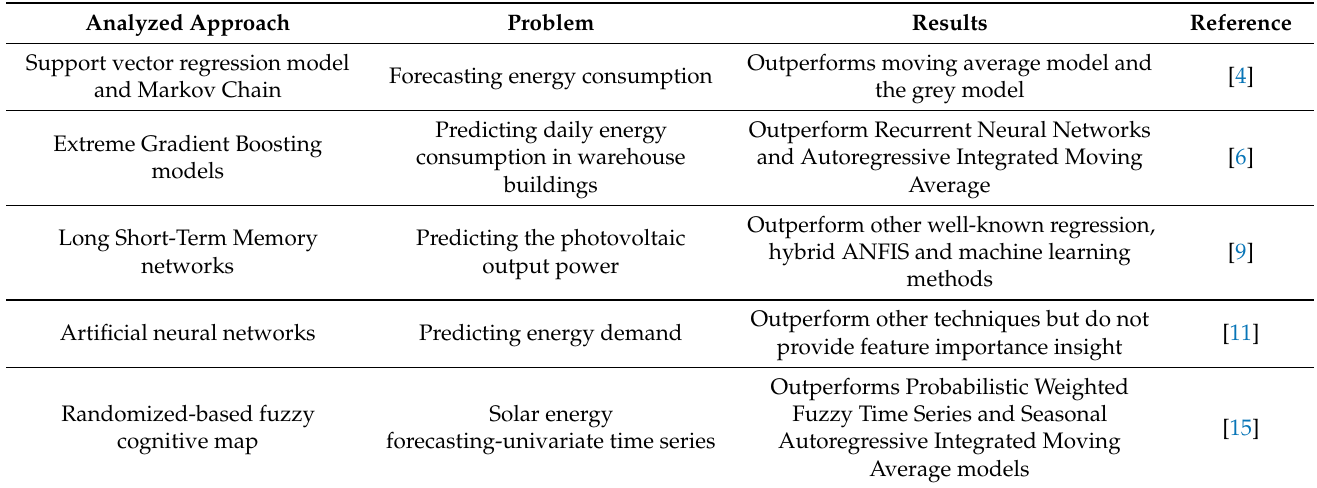
Table 1. Selected methods used for energy use